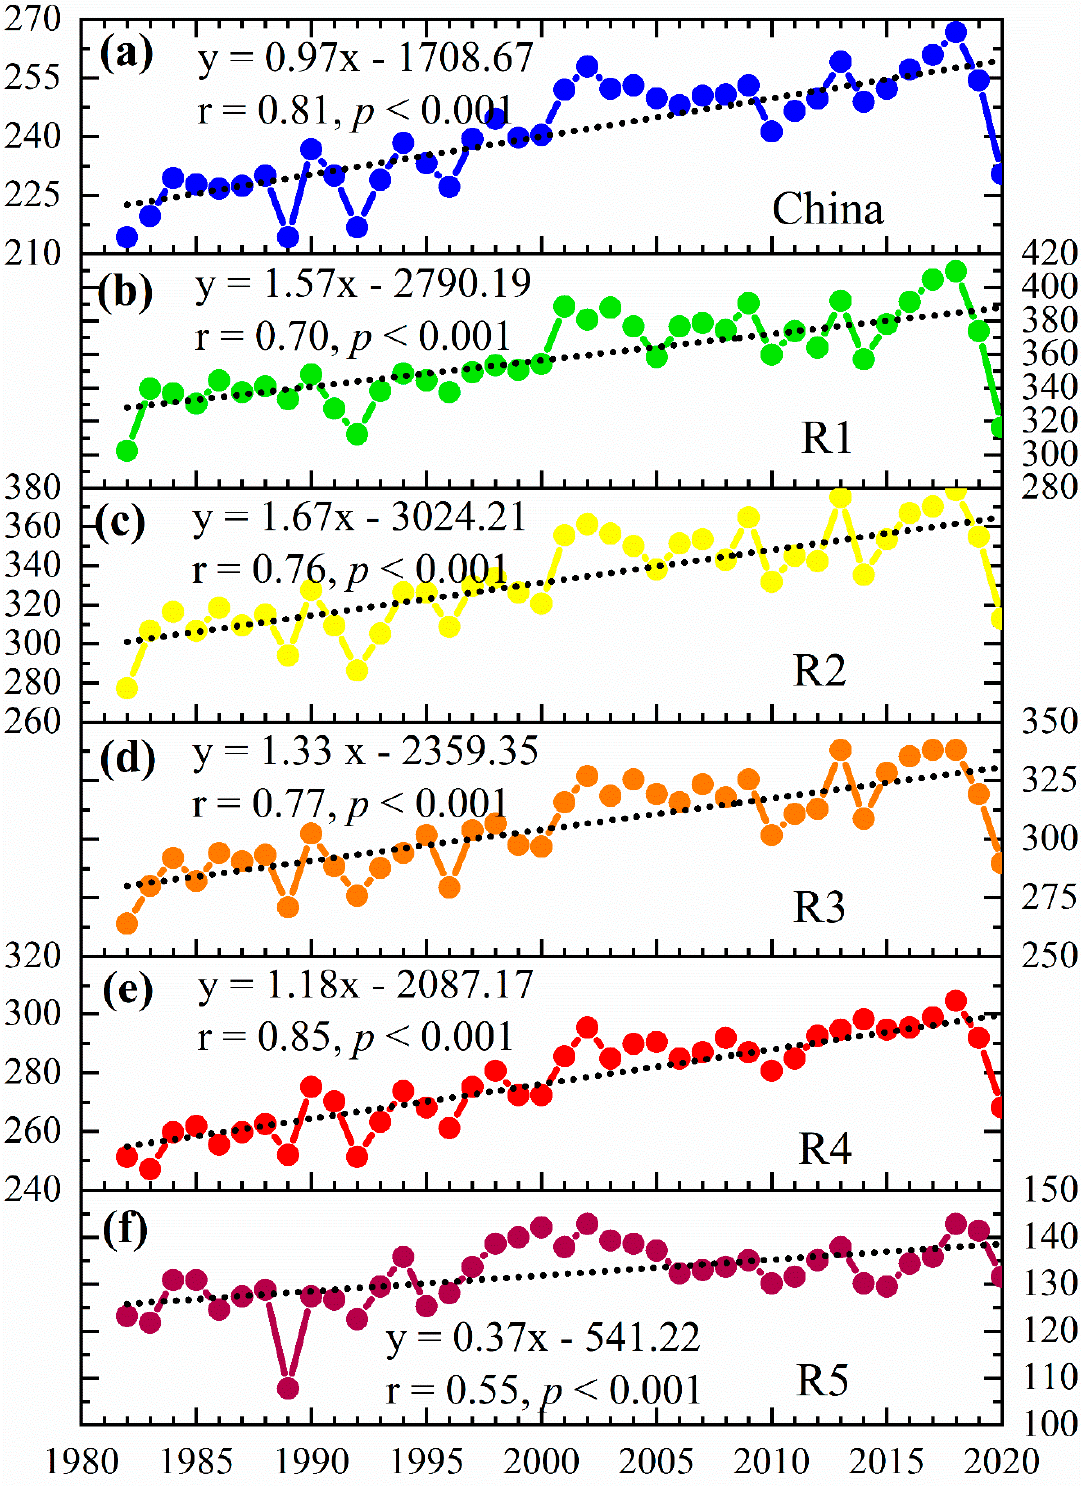
Figure 5. Annual variation in NDVI in different regions during 1982–2020. To accurately detect the variation in NDVI, all NDVI were multiplied by 100 to amplify the variation of small signals. ( a ) is annual variation in NDVI over China. ( b – f ) are annual variation in NDVI over ozone pollution region of R1, R2, R3, R4 and R5, respectively.